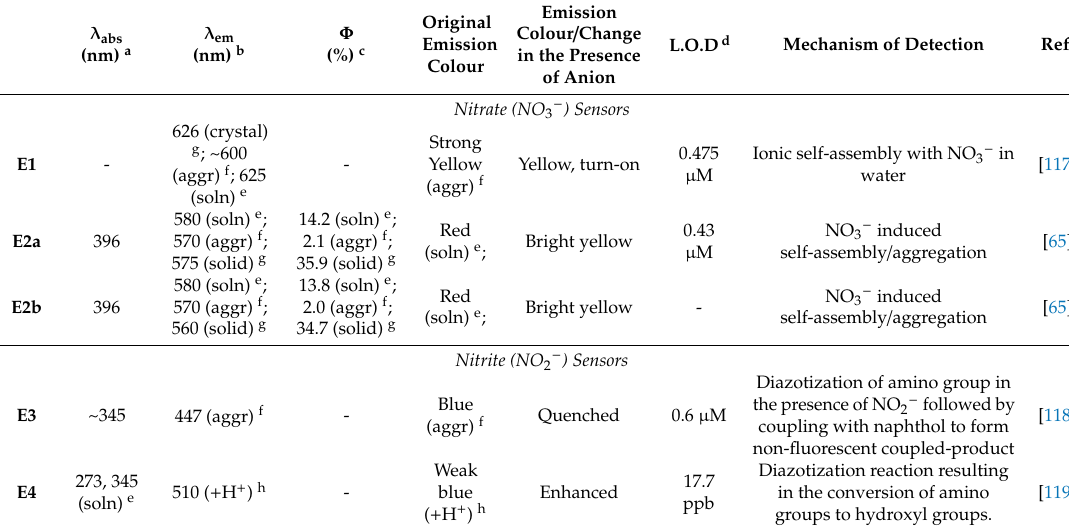
Table 8. Summary of optical properties and sensing performance of AIE-based nitrate sensors ( E1 – E2b ) and nitrite sensors ( E3 and E4 ).